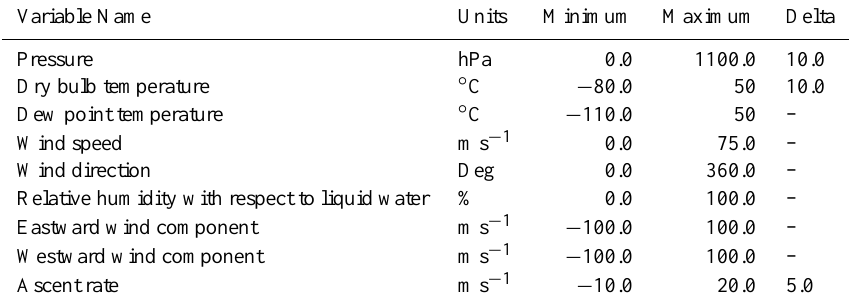
Table 3. ARM defined min, max and delta data quality check limits. These limits are automatically applied to all MC3E soundings as part of the data ingest procedures. The delta check refers to the change between two adjacent data points. Data points that are outside of these limits are automatically flagged.